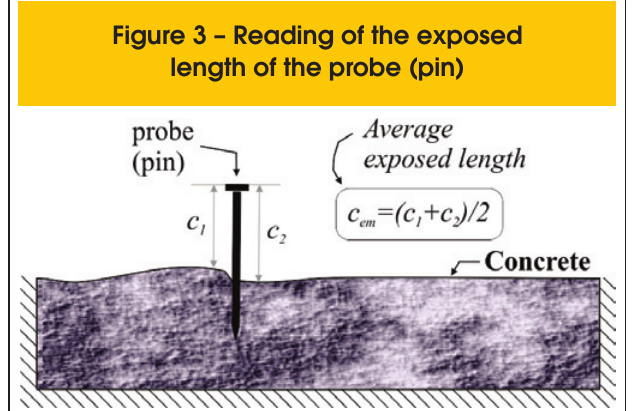
Figure 3 – Reading of the exposed length of the probe